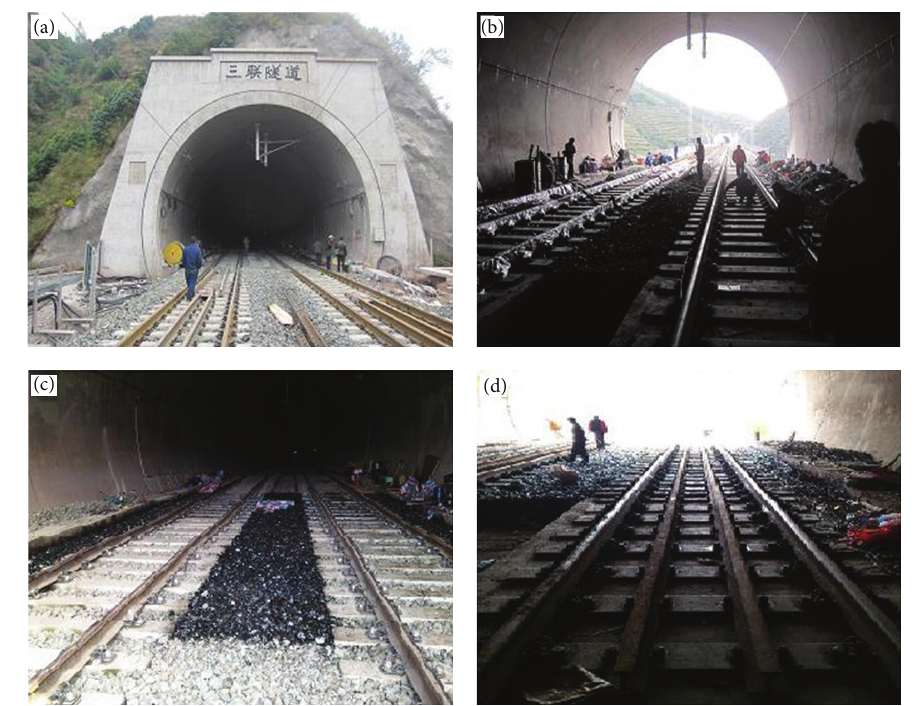
Figure3:Photosofthetransitionzone:globalgraphofthetransitionzonebeforesettlement(a),graphoftheprocessofsprayingpolyurethane polymer (b), graph of the transition zone after spraying polyurethane polymer (c), and graph of the transition zone after laying assistant rails